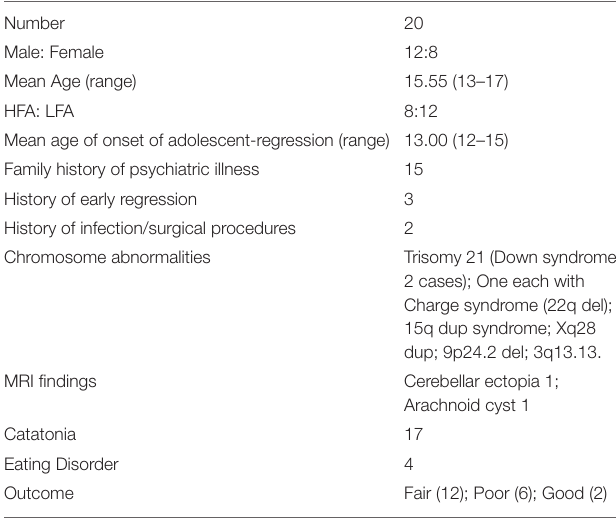
TABLE 1 | Demographic characteristics of the